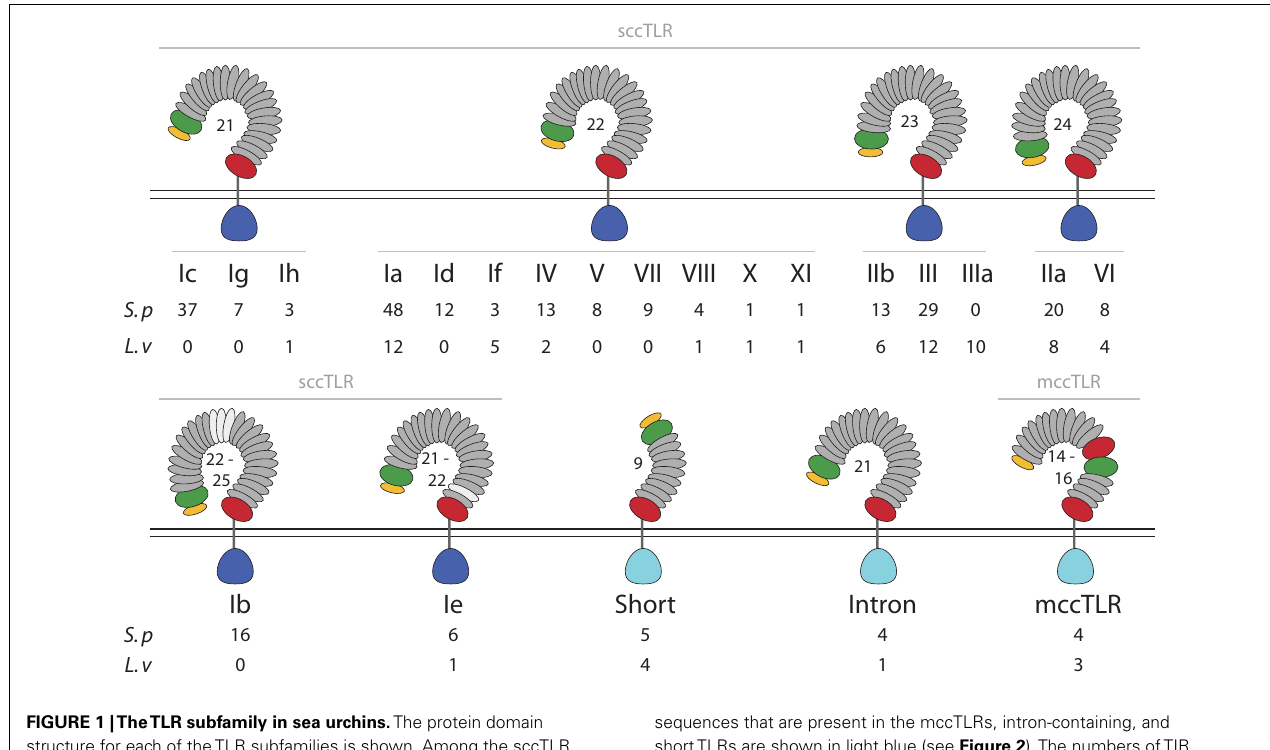
FIGURE 1 |TheTLR subfamily in sea urchins. The protein domain structure for each of theTLR subfamilies is shown. Among the sccTLR sequences, the number of LRRs varies from 21 to 25.TLRs in subfamilies Ib and Ie vary in the total number of LRRs (LRRs that are not present in all sequences are shown in light gray).The divergentTIR